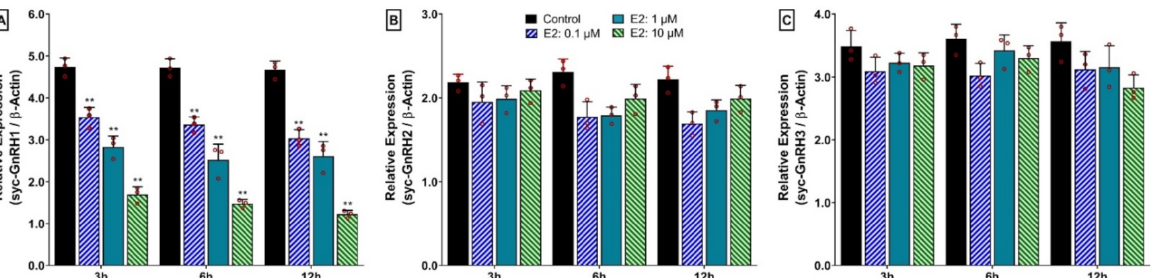
Figure 12. Time- and dose-dependent in vitro effects of 17- β estradiol (E2) on mRNA expression levels of three GnRH isoforms in cultured hypothalamus of small yellow croaker: ( A ) syc-GnRH1, ( B ) syc-GnRH2, and ( C ) syc-GnRH3. E2 was applied in the culture media at concentrations of 0.1, 1, and 10 µ M. For all bar graphs, raw data points (red circle) represent biological replicates, error bars represent standard deviation, and asterisks indicate significant differences ( p < 0.05) compared to the zero time point initial